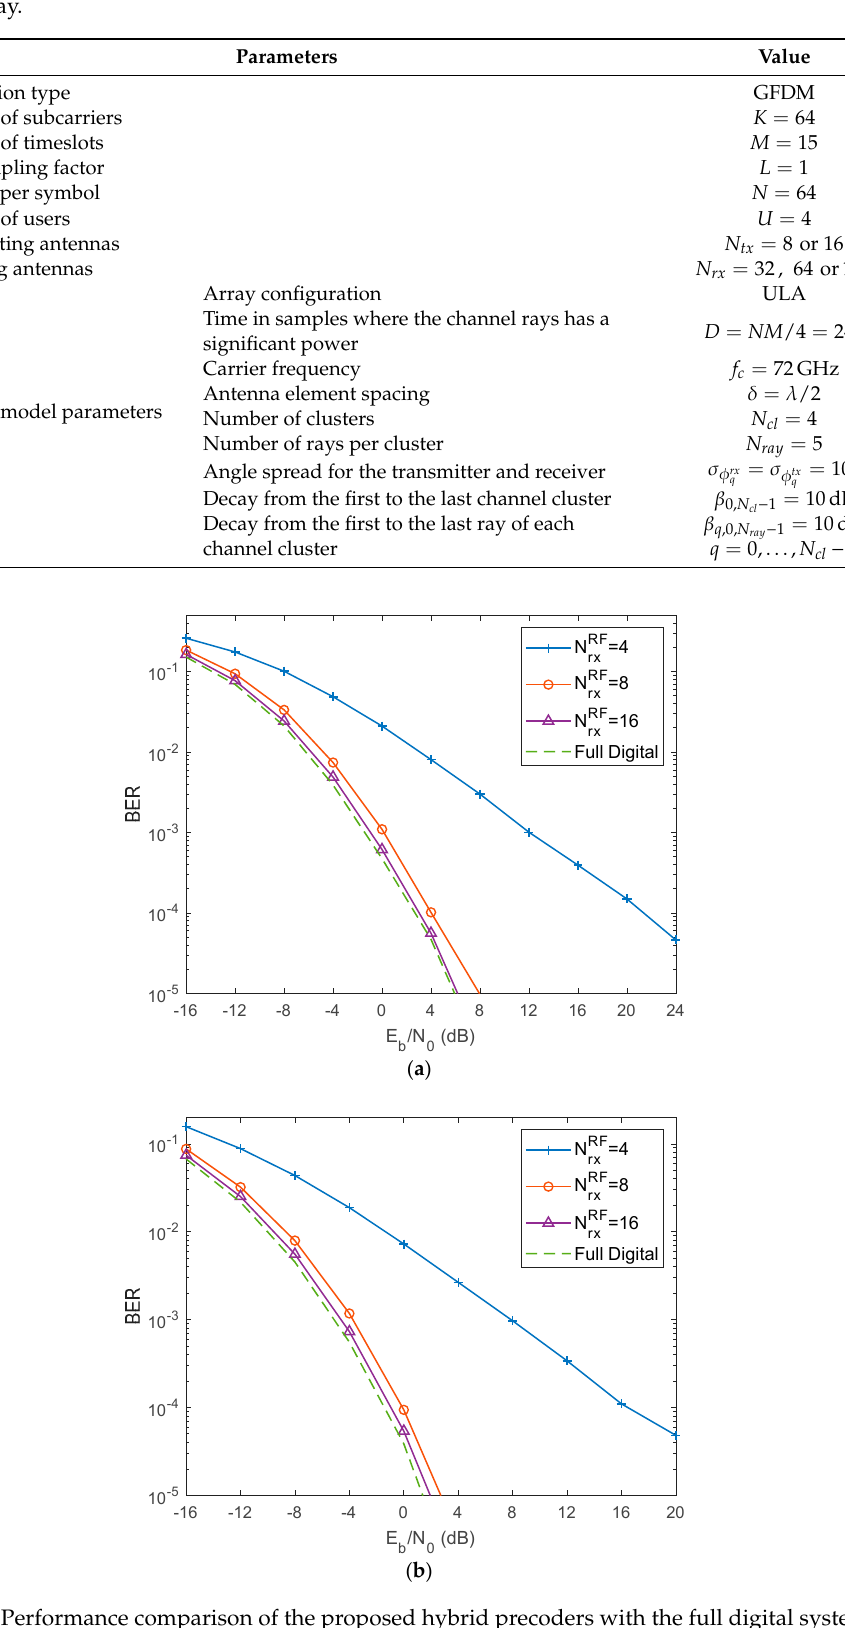
Table 1. Simulation parameters. GFDM, generalized frequency division multiplexing; ULA, uniform linear array.